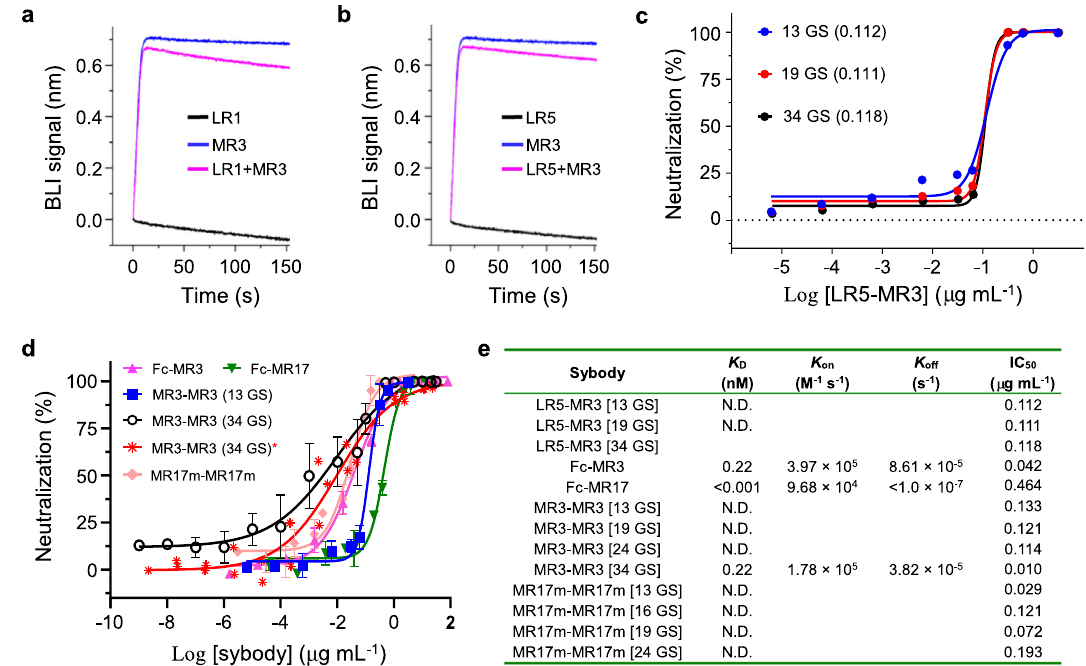
Fig. 4 Divalent engineering increases af fi nity and neutralizing activity. a , b Identi fi cation of two non-competing pairs, LR1/MR3 ( a ) and LR5/MR3 ( b ), for biparatopic constructs. For BLI assays, sensors coated with RBD were soaked in 200 nM of LR1 or LR5 before further soaked in LR1- or LR5-containing buffer with (magenta) or without (black) 100 nM of MR3. The MR3 – RBD interaction pro fi le was obtained in the absence of LR1 or LR5 (blue). c Neutralization assay of the biparatopic sybody LR5-MR3 with a Gly-Ser (GS) linker of 13 (blue), 19 (red), or 34 (black) amino acids as indicated. Brackets indicate IC 50 values in μ g mL − 1 . Data are from a representative of two independent experiments. d Neutralization assays of divalent sybodies. The original SARS-CoV-2 was used for all assays except that the D614G mutant 42 was additionally tested for MR3-MR3 (red asterisk). Color-coding of the tested sybodies is as indicated. For MR3-MR3(34GS) against 614G, data show a representative of three independent experiments, which were performed using non-overlapping concentrations. For the rest of the samples, mean± standard deviation are plotted ( n = 3 independent experiments). Error bars are omitted where, in rare cases, available data points are less than three due to experimental design on concentration replicates. e Summary of binding kinetics and neutralizing activities of the divalent sybodies. Source data for a – d are provided as a Source data fi le. BLI biolayer interferometry, N.D. not